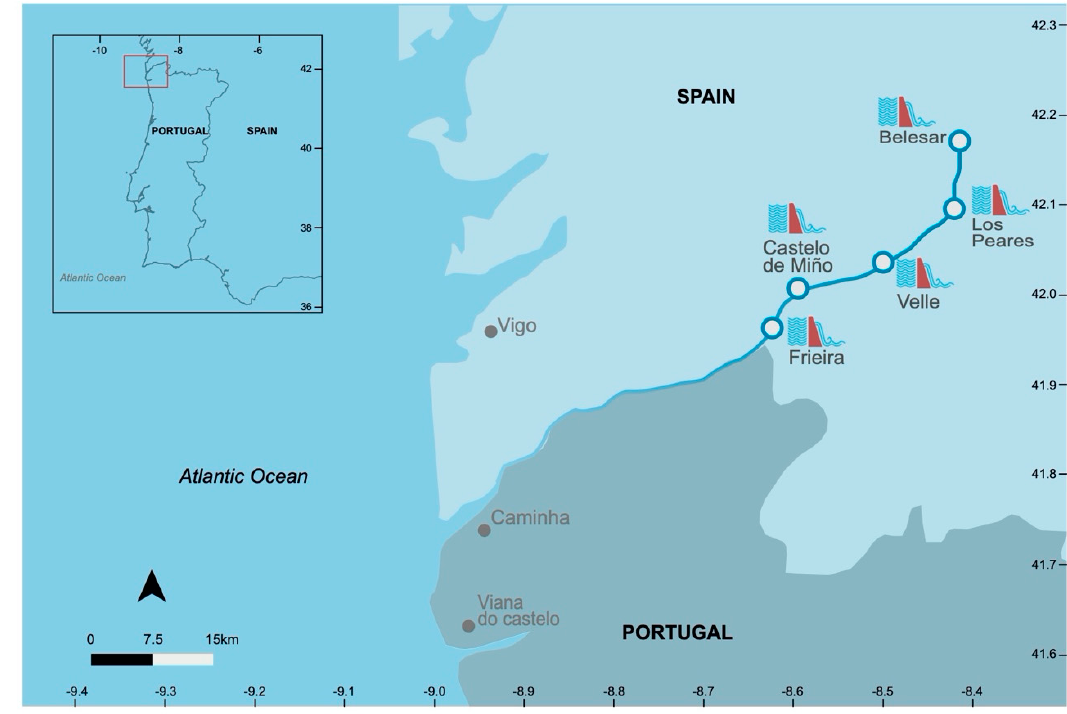
Figure 1. Map of the Minho River international section and the location of major dams constructed in the past 100 years.